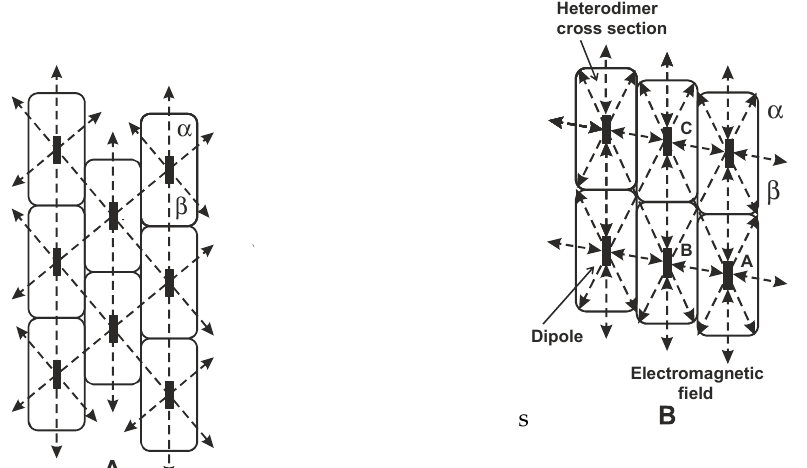
Figure 2. Schematic drawings of small parts of the cylindrical surface of microtubule lattices ( A ) and ( B ) along their axes [20,21]. The helical periodicity is 13 heterodimers per turn with a slope corresponding to a dimension of three monomers. Electric dipoles are assumed to be located in the centers of the heterodimers and to be orientated approximately along the microtubule axis. Electromagnetic energy propagates along the dashed lines between the dipoles of heterodimers forming protofilaments along the microtubule axis. In the lattice A bondings between protofilaments occur between different monomers ( α – β ), and in the lattice B between the same monomers ( α – α or β – β ) outside the seam and between different monomers ( α – β ) only in the seam of the microtubule lattice. There are two principal types of periodicities: along the microtubule axis (distance between the turns) and along the helix and helix–axial combinations. Electromagnetic analysis in this paper is based on the lattice B (outside the seam) and interactions are assumed along the lines with arrows at the dipoles.